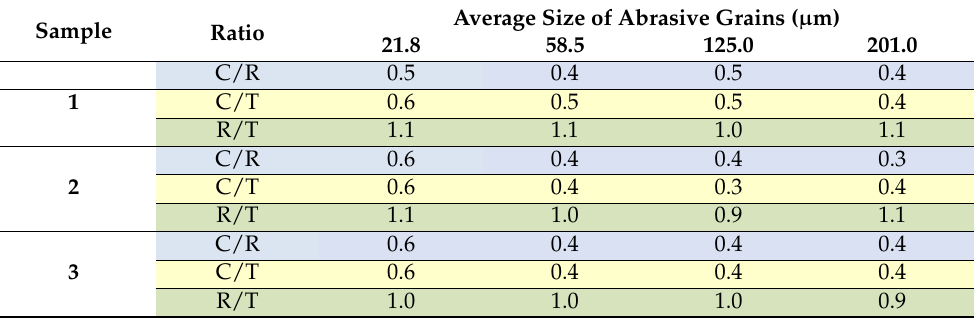
Table 4. The values of the ratio between the volume loss of Samples 1–3 in the cross (C), radial (R), and tangential (T) sections for all grits of